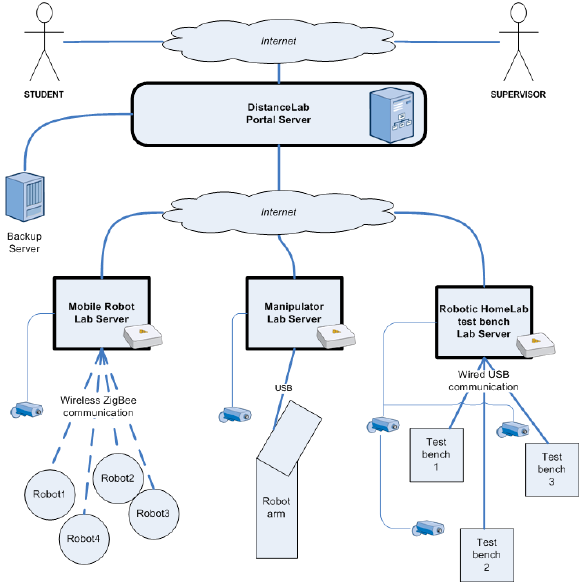
Figure 2. The structure of DistanceLab e-environment tanceLab portal by the users with sufficient rights. Robots